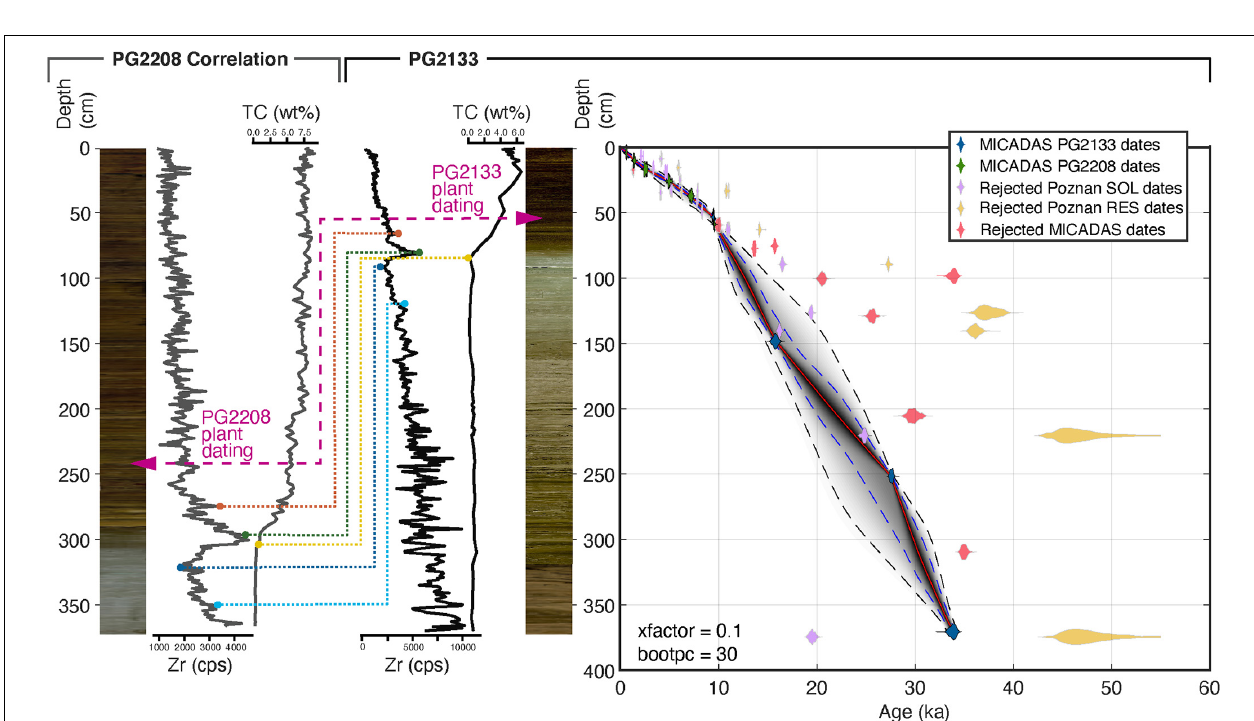
FIGURE 2 | Age-depth model based on 22 radiocarbon dated samples from sediment cores PG2133, PG2208, and two surface samples (PG2112, PG2119) from Lake Bolshoe Toko, southeastern Yakutia, Siberia. Age-depth model created with the MATLAB software package ‘Undatable’ (Lougheed and Obrochta, 2019) and the IntCal20 calibration curve (Reimer et al., 2020). Modeled ages are expressed as calibrated thousand years (ka) before present. The Holocene part was correlated between sediment core PG2208, retrieved from the deeper central part of the lake, and sediment core PG2133. Correlation was performed using Zr values from XRF core scanner data shown as counts per seconds (cps) and the concentrations of total carbon (wt%). The purple arrows indicate the position of plant remains in photographs of the sediment cores, dated to similar ages found at different depths of both cores. Dashed lines indicate tie points between cores used to report age information from the higher resolution Holocene part from core PG2208 onto PG2133 used in this study.